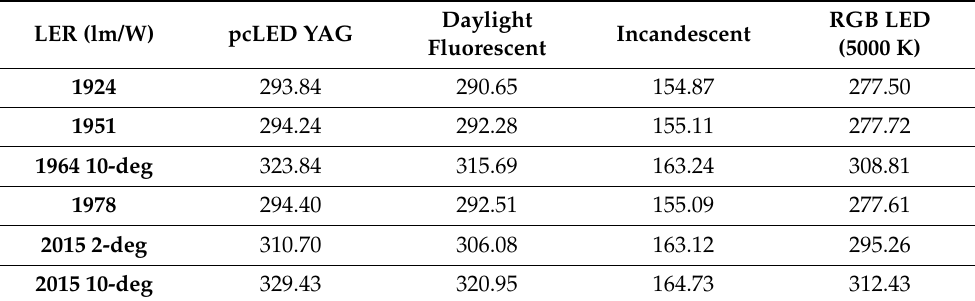
Table 2. LER results for four different light sources.